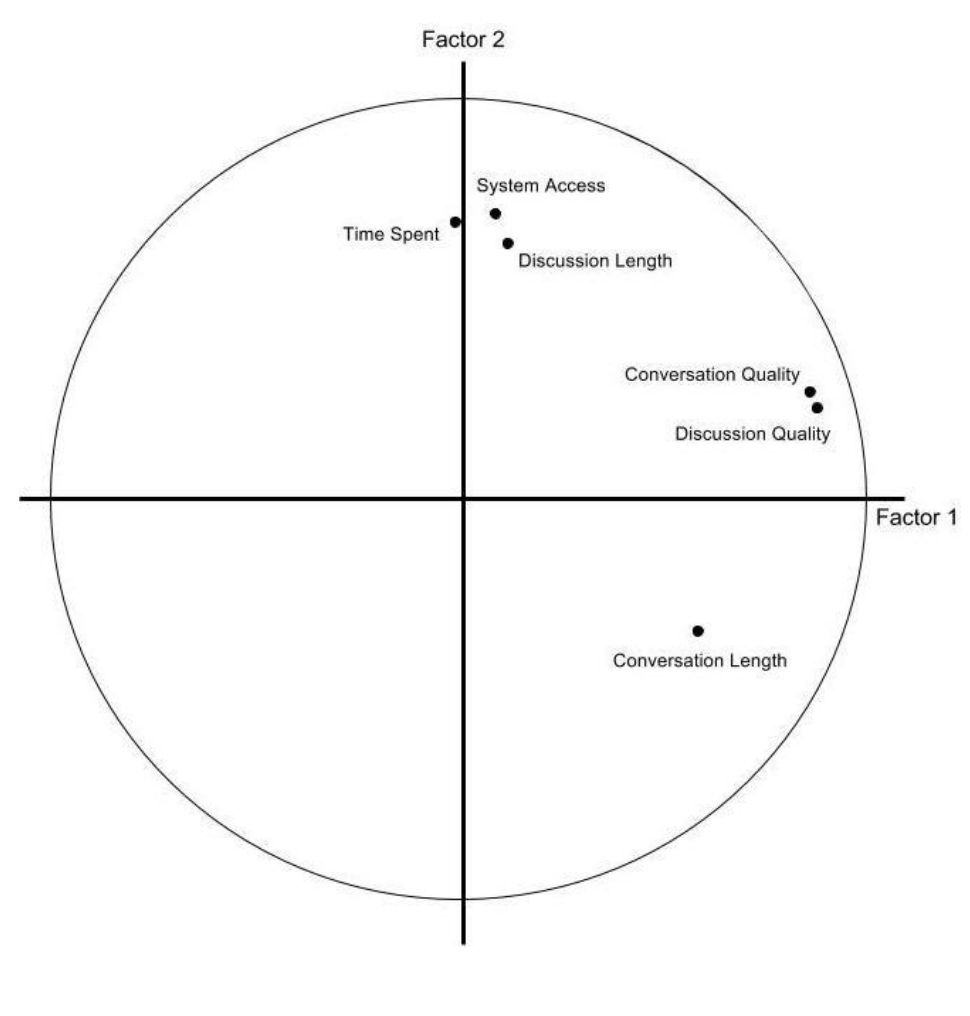
Figure 2 . The component plot in rotated